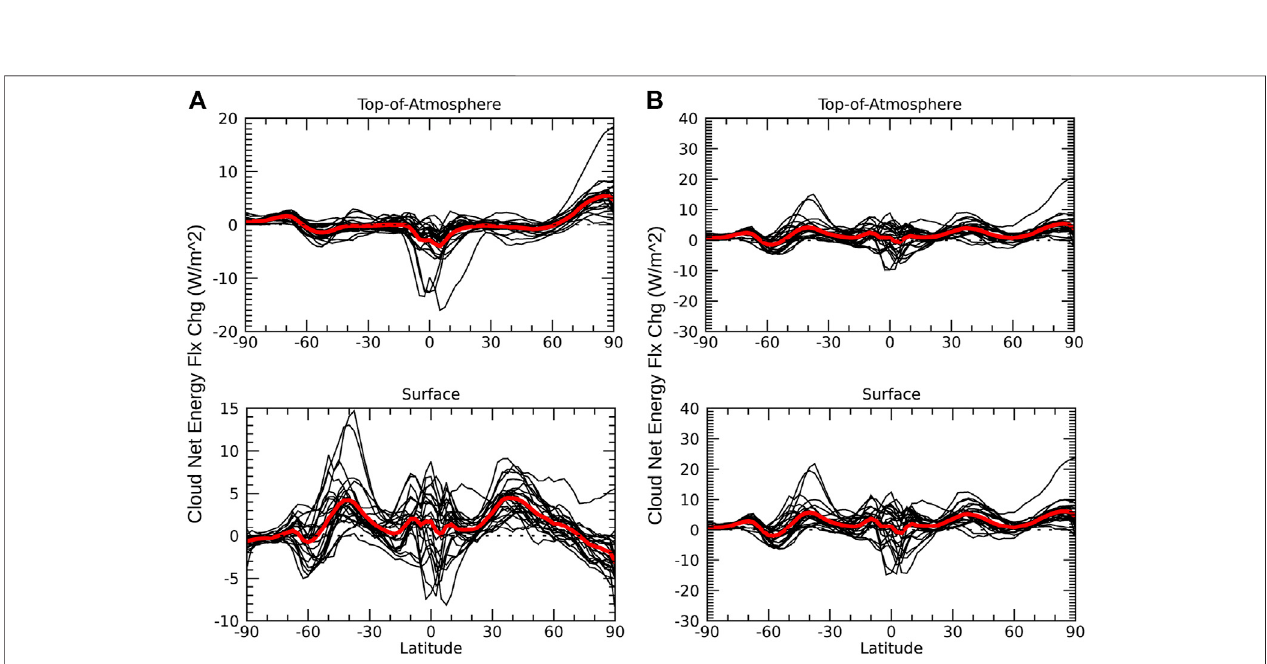
FIGURE 8 | Same as Figure 5 but due to the net cloud feedback.